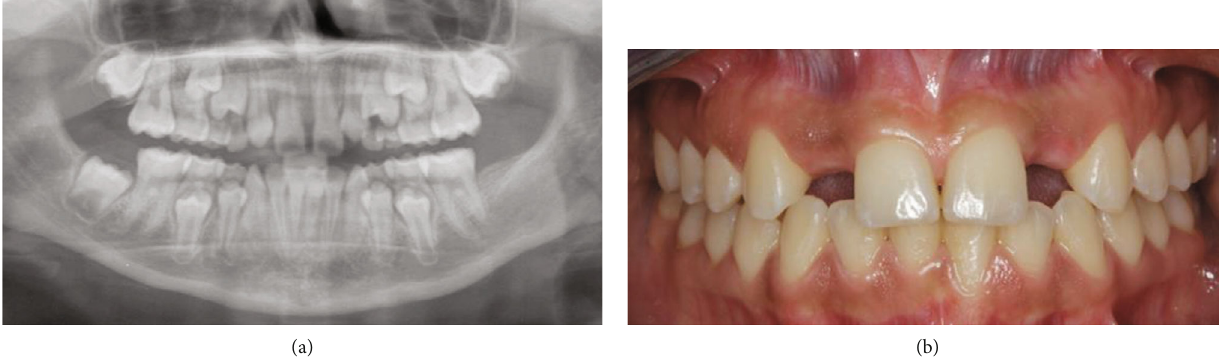
Figure 1: (a) Panoramic radiograph showing agenesis of both maxillary lateral incisors. (b) Facial view at the end of the orthodontic treatment showing the space maintained with the removable orthodontic retainer.